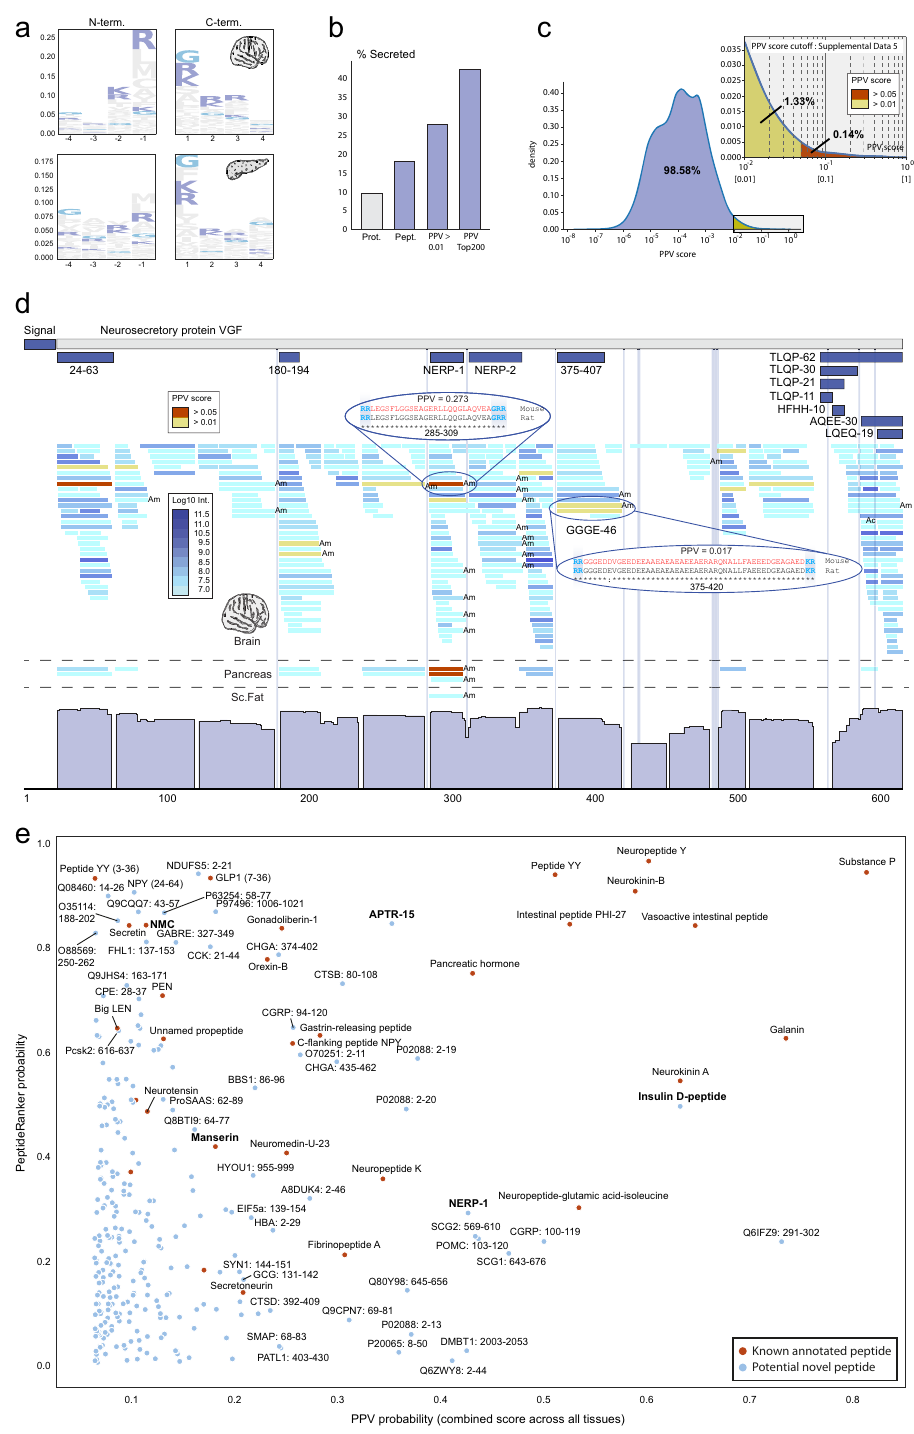
Fig. 5|PPV modelvalidationandpredictions.a Logo-plot of N- and C-terminal fl anking regions surrounding high scoring PPV predicted peptides in brain and pancreas. Lysine (K) and Argenine (R) are marked in dark blue, and Glycine (G) in light blue. Calculated by Kullback-Leibler divergence between PPV predic- tions with a score above 0.01 and the 80% lowest scoring background PPV predictions. All known annotated peptides were removed. b Secretion status determinedbymembershiponproteinprecursorlevelbasedonsignalpeptide annotation and signalP predictions. Mouse proteome (Prot.), the global pep- tidome (Pept.) data in this study, PPV predictions with scores above 0.01 and Top200 PPV predictions across all tissues. All known peptides were removed. c PPVscoredensitydistributioninthedata.X-axisisthePPV-score(Log 10 ),and